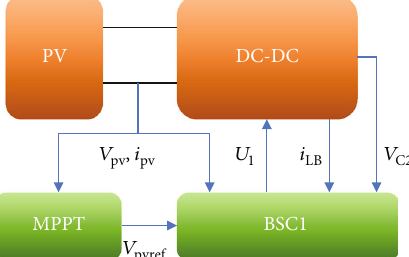
Figure 5: Block diagram of the fi rst stage (boost converter).